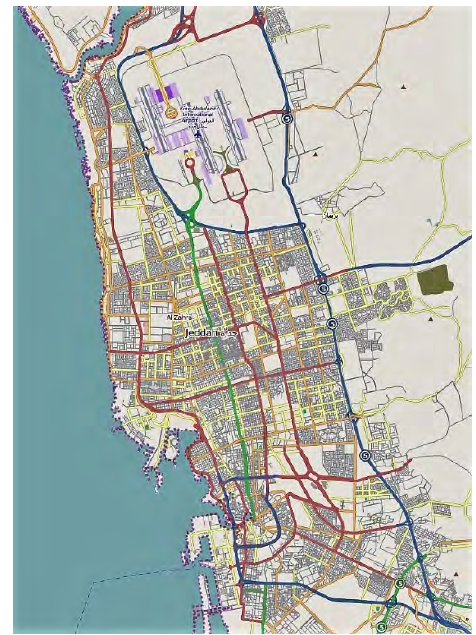
Figure 2. Jeddah and Corniche Map Source: Jeddah Municipality